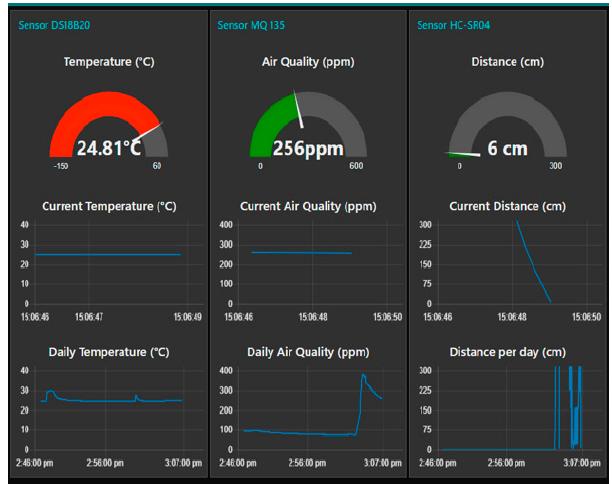
Figure 11. The Graphical User Interface: the value measured by the SmartJacket.